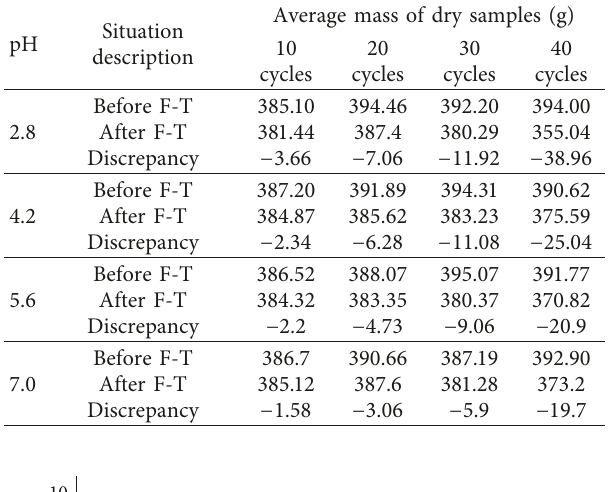
Figure 5: Porosity of sandstone after recurrent F-T cycles in acid solution with different